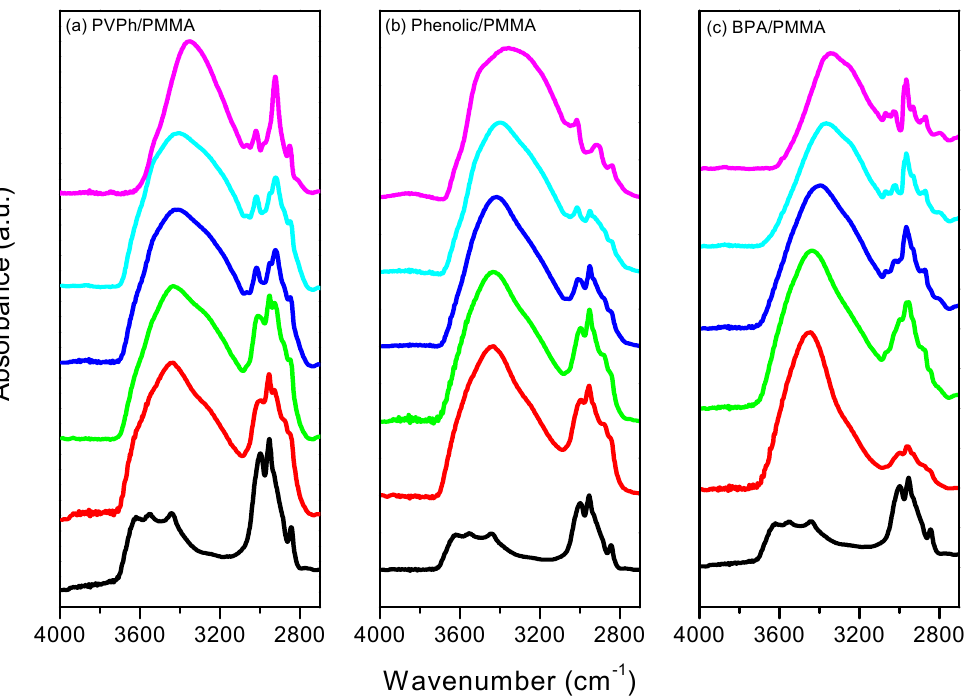
Figure 7. FTIR spectra (4000–2700 cm − 1 region) recorded at room temperature for ( a ) PVPh/PMMA; ( b ) phenolic/PMMA; and ( c ) BPA/PMMA blends containing various PMMA